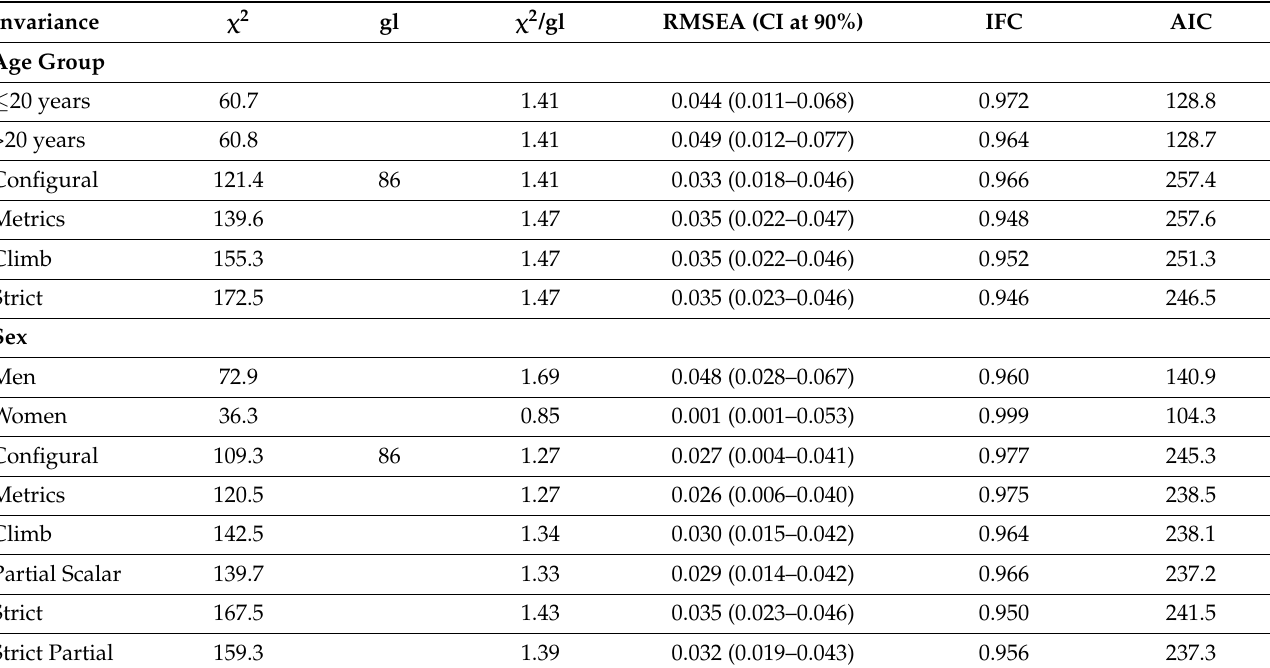
Table 5. Goodness-of-fit indices of invariance models by age group ( ≤ 20 and >20 years) and